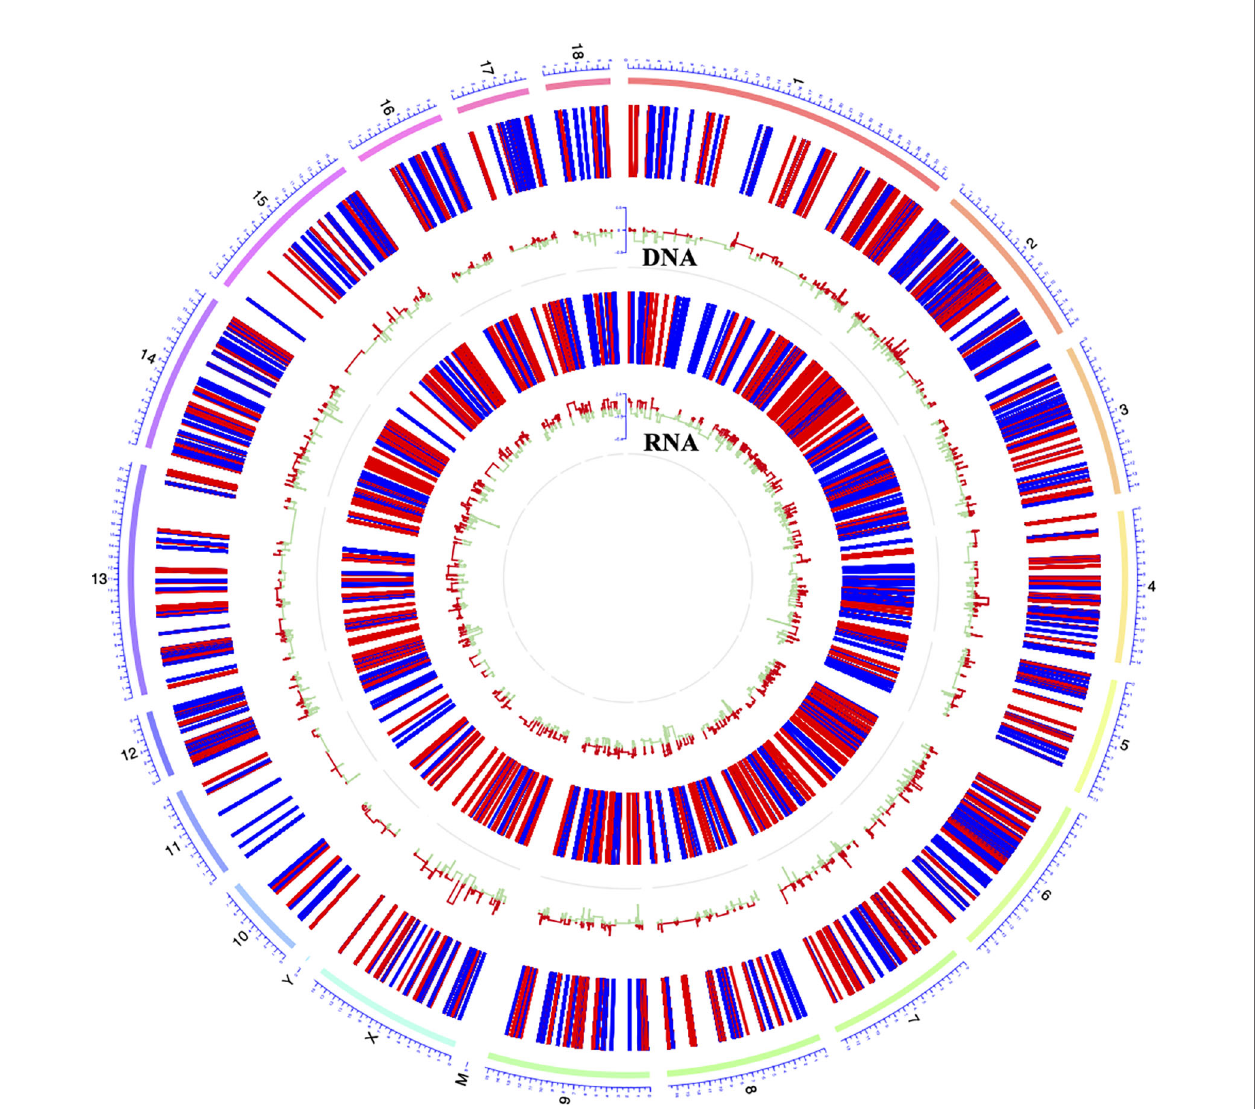
FIGURE 4 | Circos plot showing DNA methylation and mRNA transcription on pig chromosomes. The outermost circle displays the pig chromosomes; The second layer from the outside represents the genome-wide distribution of differentially methylated CpGs in promoter regions; The innermost layer represents the differentially expressed mRNAs identi fi ed by RNA-seq. Red bars indicate hypermethylation or up-expression, and blue/green bars indicate hypomethylation or